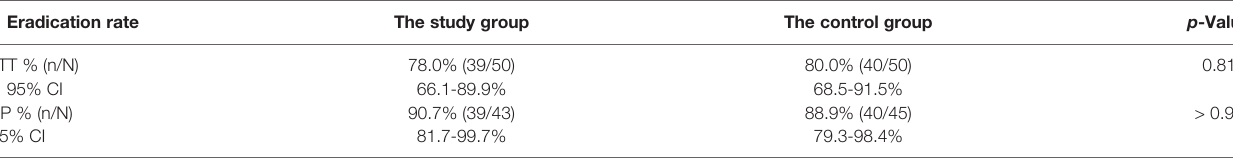
TABLE 5 | The total eradication rate of the two therapeutic regimens.